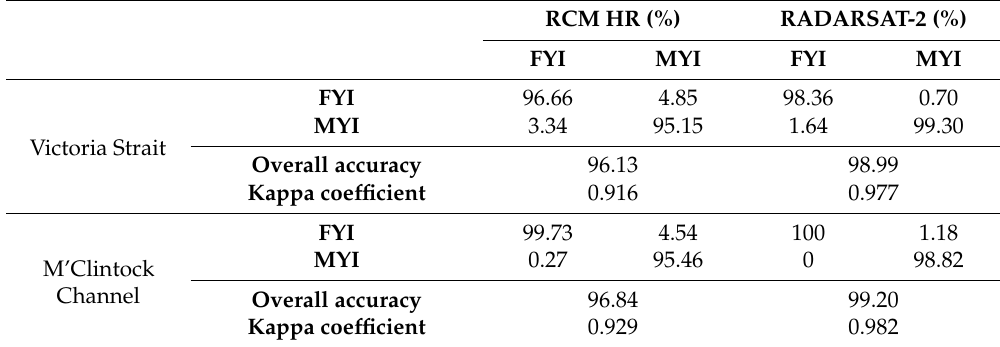
Table 6. Evaluation of the FYI and MYI classification results for simulated RCM HR CP SAR data and RADARSAT-2 full polarimetric SAR data over Victoria Strait and M’Clintock Channel test